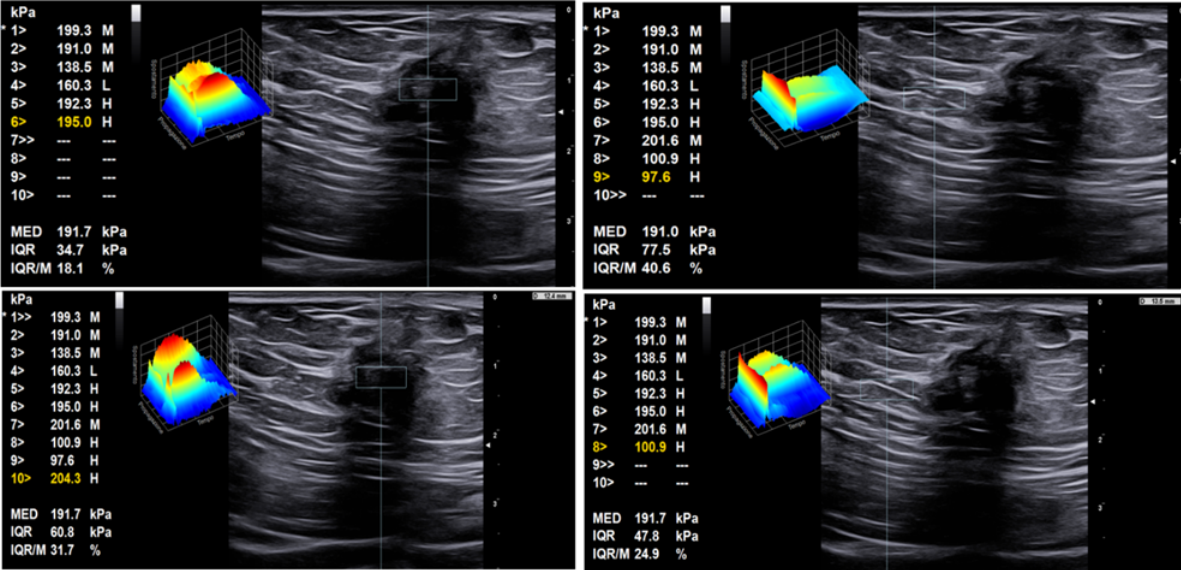
Figure 9. Share wave elastosonography mode revealing the hard pattern of the endometriotic nodule with respect to the surrounding tissue. Left: ROI within the tumor, with high shear wave pressures between 195 and 204 kPa; right: ROI within soft tissue surrounding the tumor, with distinctly lower shear wave pressures of 98–101 kPa.